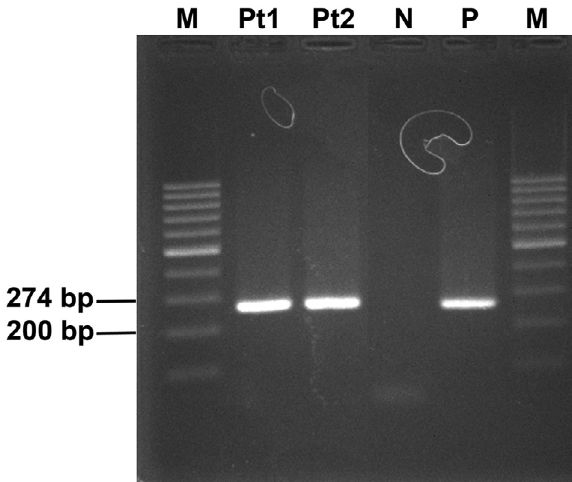
Figure 4. Electrophoresis of the polymerase chain reaction prod- ucts generated a band of 274 bp in good agreement with the expected size. M,100 bp marker; Pt1, sample from patient 1; Pt2, sample from patient 2; N, negative control; and P, positive control.